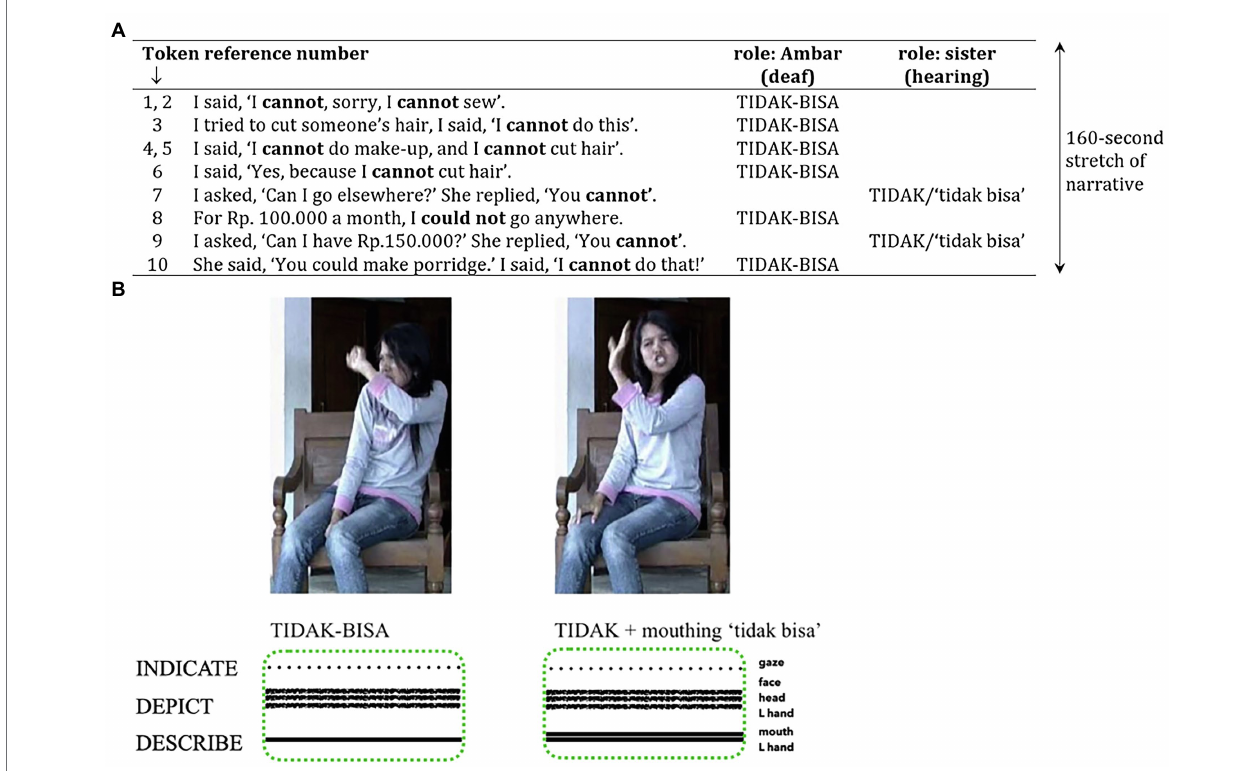
FIGURE 11 | (A) English translation of Ambar’s composite utterances (adapted from Palfreyman (2020): 104 and reproduced with permission from the author and John Benjamins Publishing Company, Amsterdam/Philadelphia, https://www.benjamins.com/catalog/aplv). (B) Two sign variants for negating the predicate ‘can’ recreated by Ambar (adapted from Palfreyman, 2020: 105 and reproduced with permission from the author and John Benjamins Publishing Company, Amsterdam/ Philadelphia,